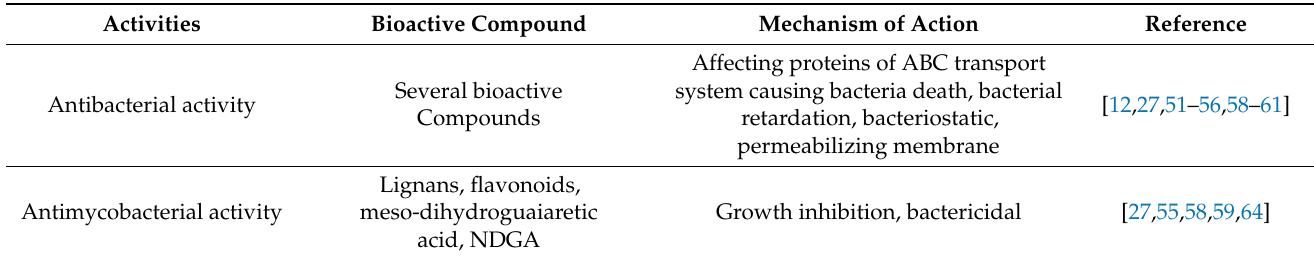
Table 5. Pharmacological activities of Larrea tridentata related to infectious